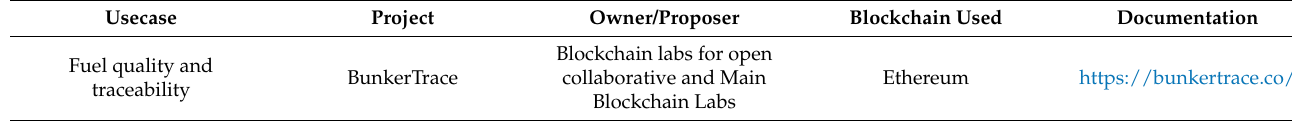
Table 1. Blockchain projects’ use cases in the maritime